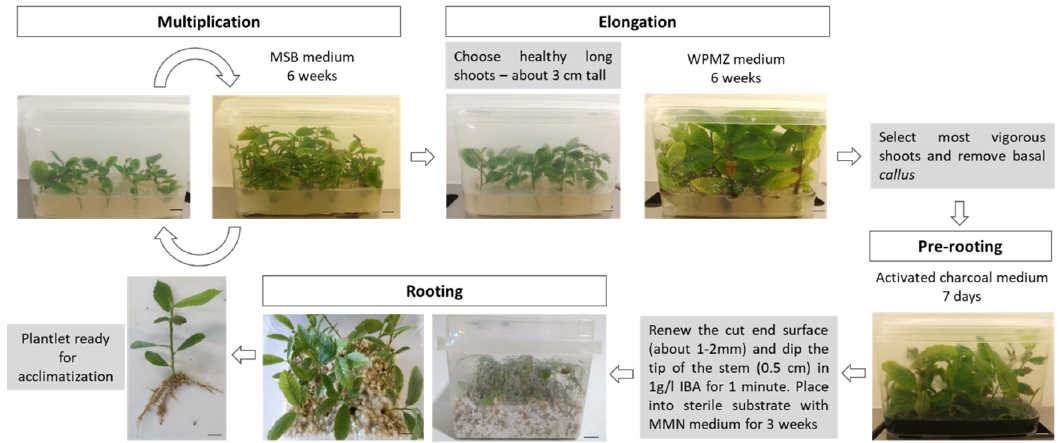
Figure 6. Schematic summary of the proposed protocol for hybrid chestnuts propagation. Bars = 1 cm.